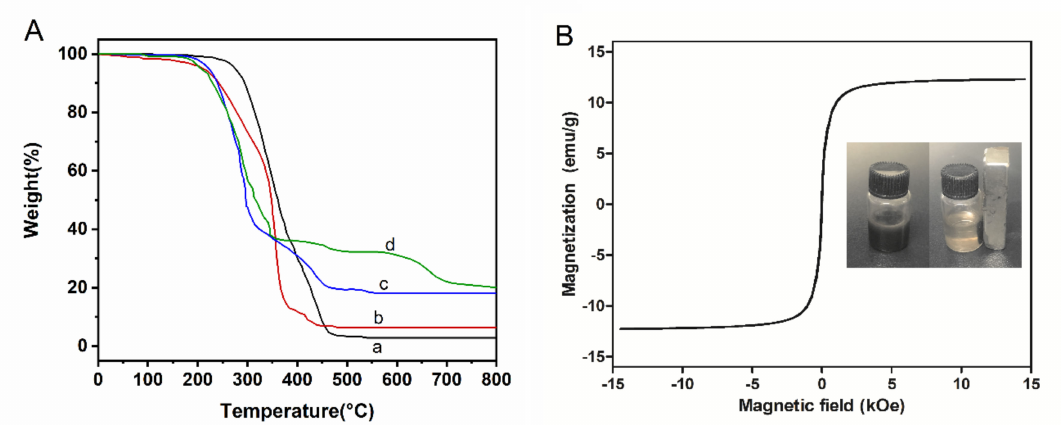
Figure 4. ( A ) TGA of (a) PGMA microspheres, (b) Amino microspheres, (c) Amino magnetic mi- crospheres, and (d) Carboxyl magnetic microspheres. ( B ) Hysteresis curve of carboxyl magnetic microspheres. The inset shows photos of the carboxyl magnetic microsphere in aqueous solution without (left) and with (right) a magnet.